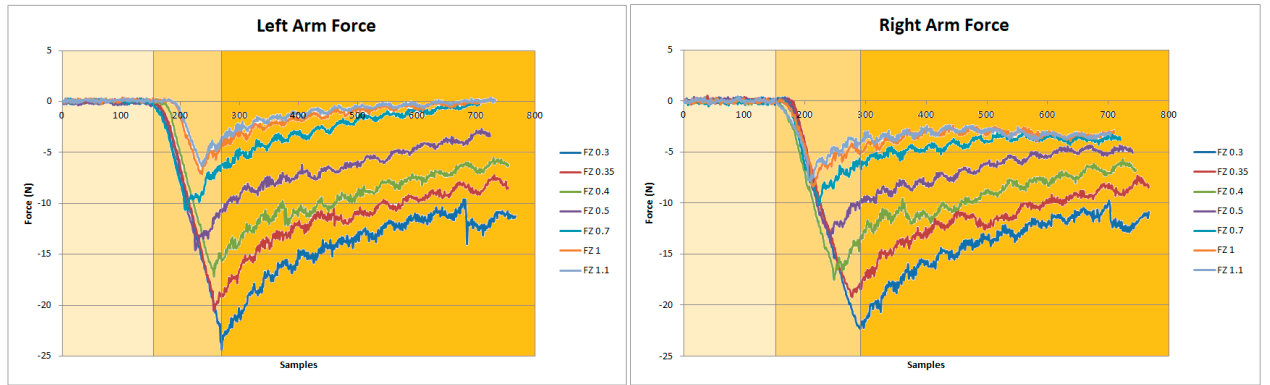
Figure 10. Forces needed to lift the box with different friction